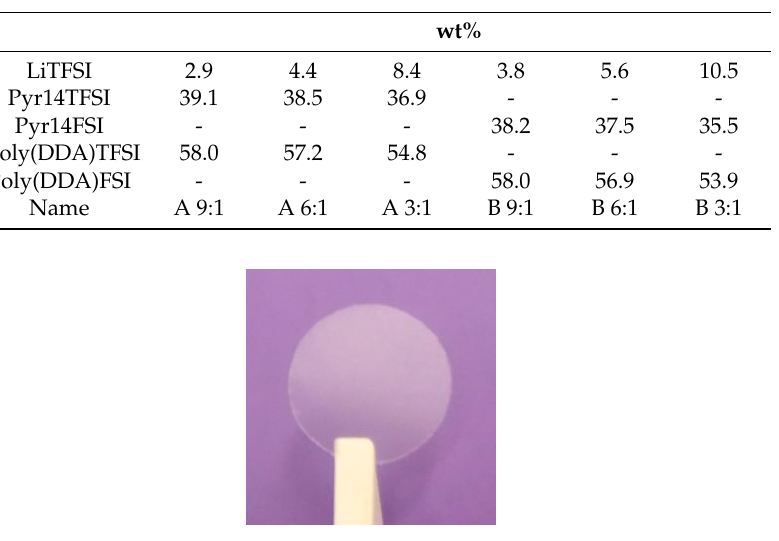
Figure 9. A typical PIL el film.